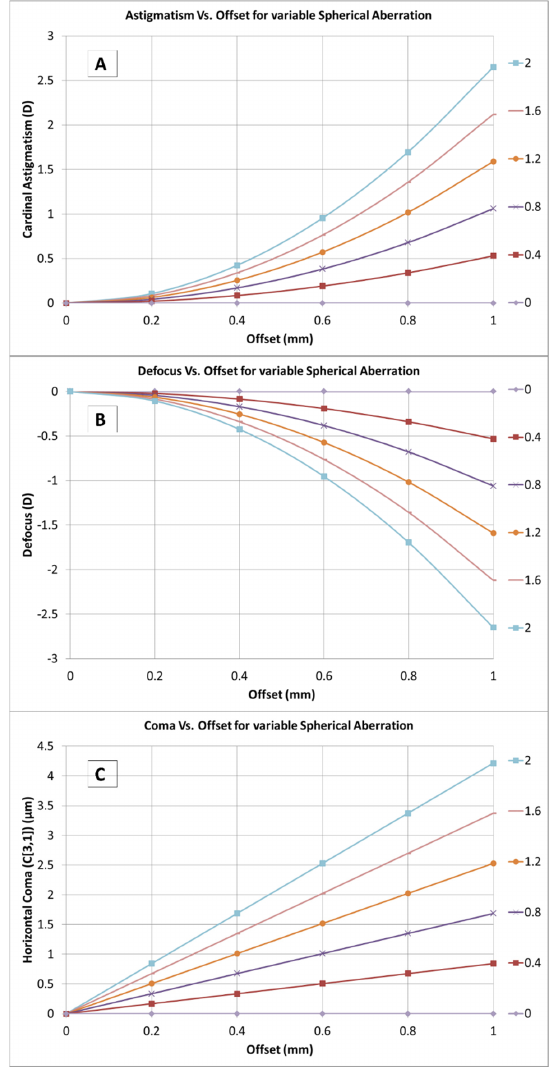
Figure 2. A progression of aberrations with respect to o ff set (0 to + 1 mm) for a variable amount of spherical aberrations (SA) (0 to + 2 µ m). Here, o ff set represents translation; however, the results are presented with the terminology more popular in the field of refractive surgery. ( A ) Progression of cardinal astigmatism with respect to o ff set for variable SA. For an SA of + 0.4 µ m, a translation of 1 mm theoretically results in + 0.53D of cardinal astigmatism. ( B ) Progression of defocus with respect to o ff set for variable SA. For an SA of + 0.4 µ m, a translation of + 1mm theoretically results in − 0.53D of defocus. ( C ) Progression of horizontal coma (C[3,1]) with respect to o ff set for variable SA. For an SA of + 0.4 µ m, a translation of + 1 mm theoretically results in + 0.84 µ m of horizontal coma